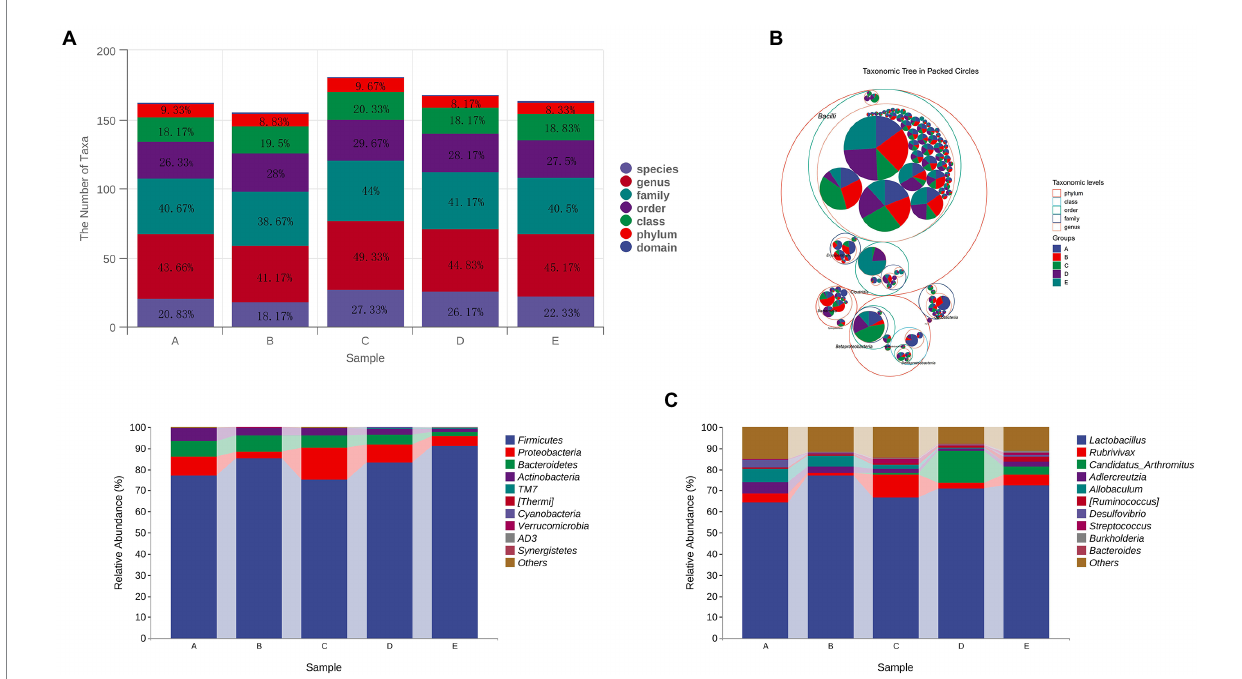
FIGURE 11 The effect of CSPCM on taxonomic composition in mice samples. (A,B) The effect of CSPCM on taxonomic composition in mice samples. (C) Effect of CSPCM on intestinal flora composition at phylum level. (D) Effect of CSPCM on intestinal flora composition at genus